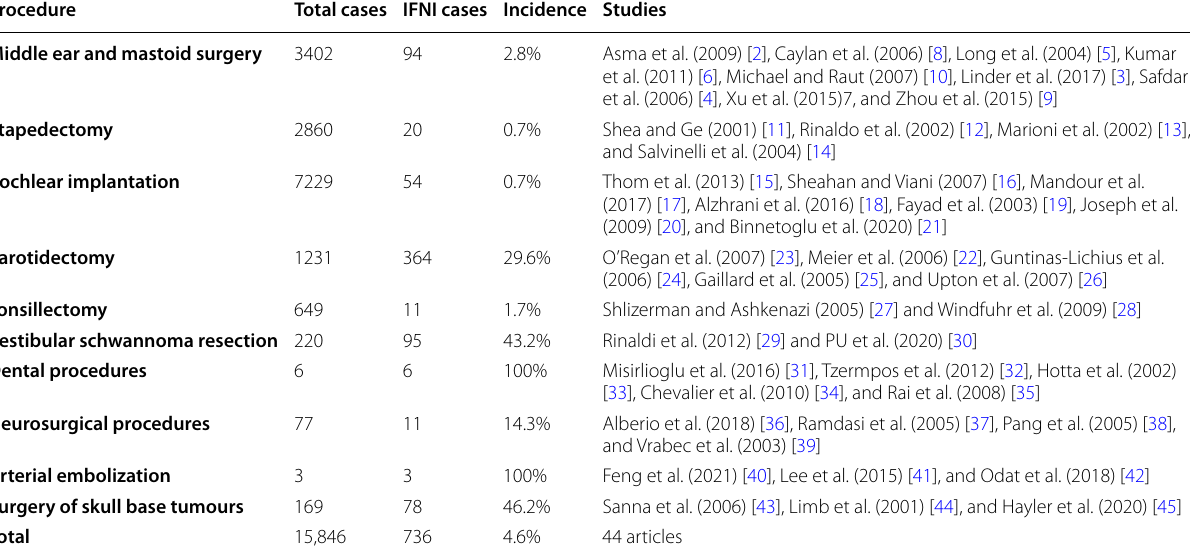
Table 2 Incidence and aetiology of facial nerve